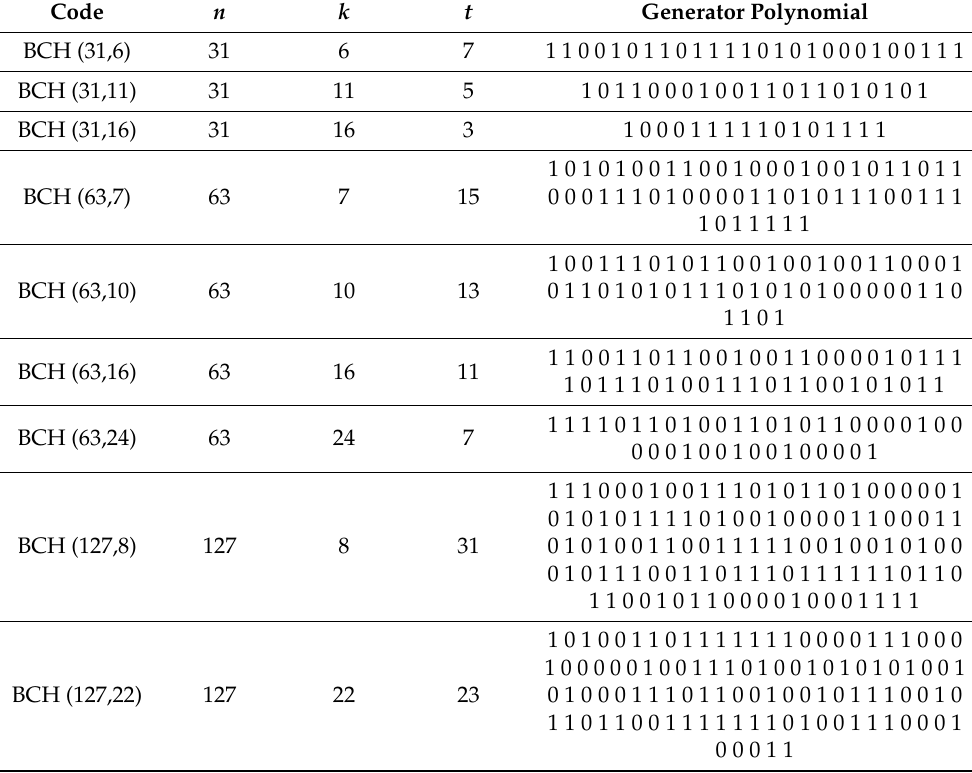
Table 1. BCH coding